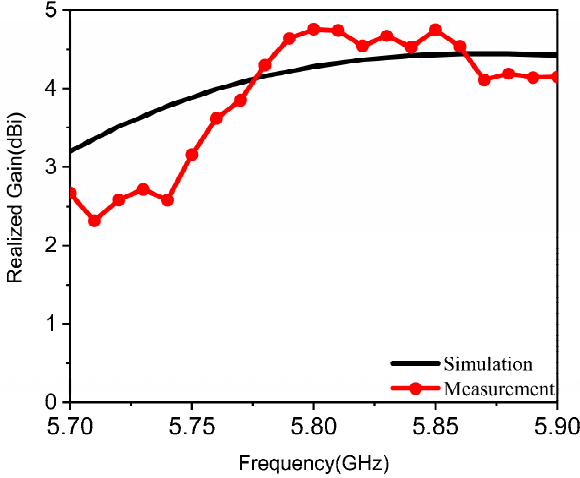
Figure 10. The simulated and measured realized gains.